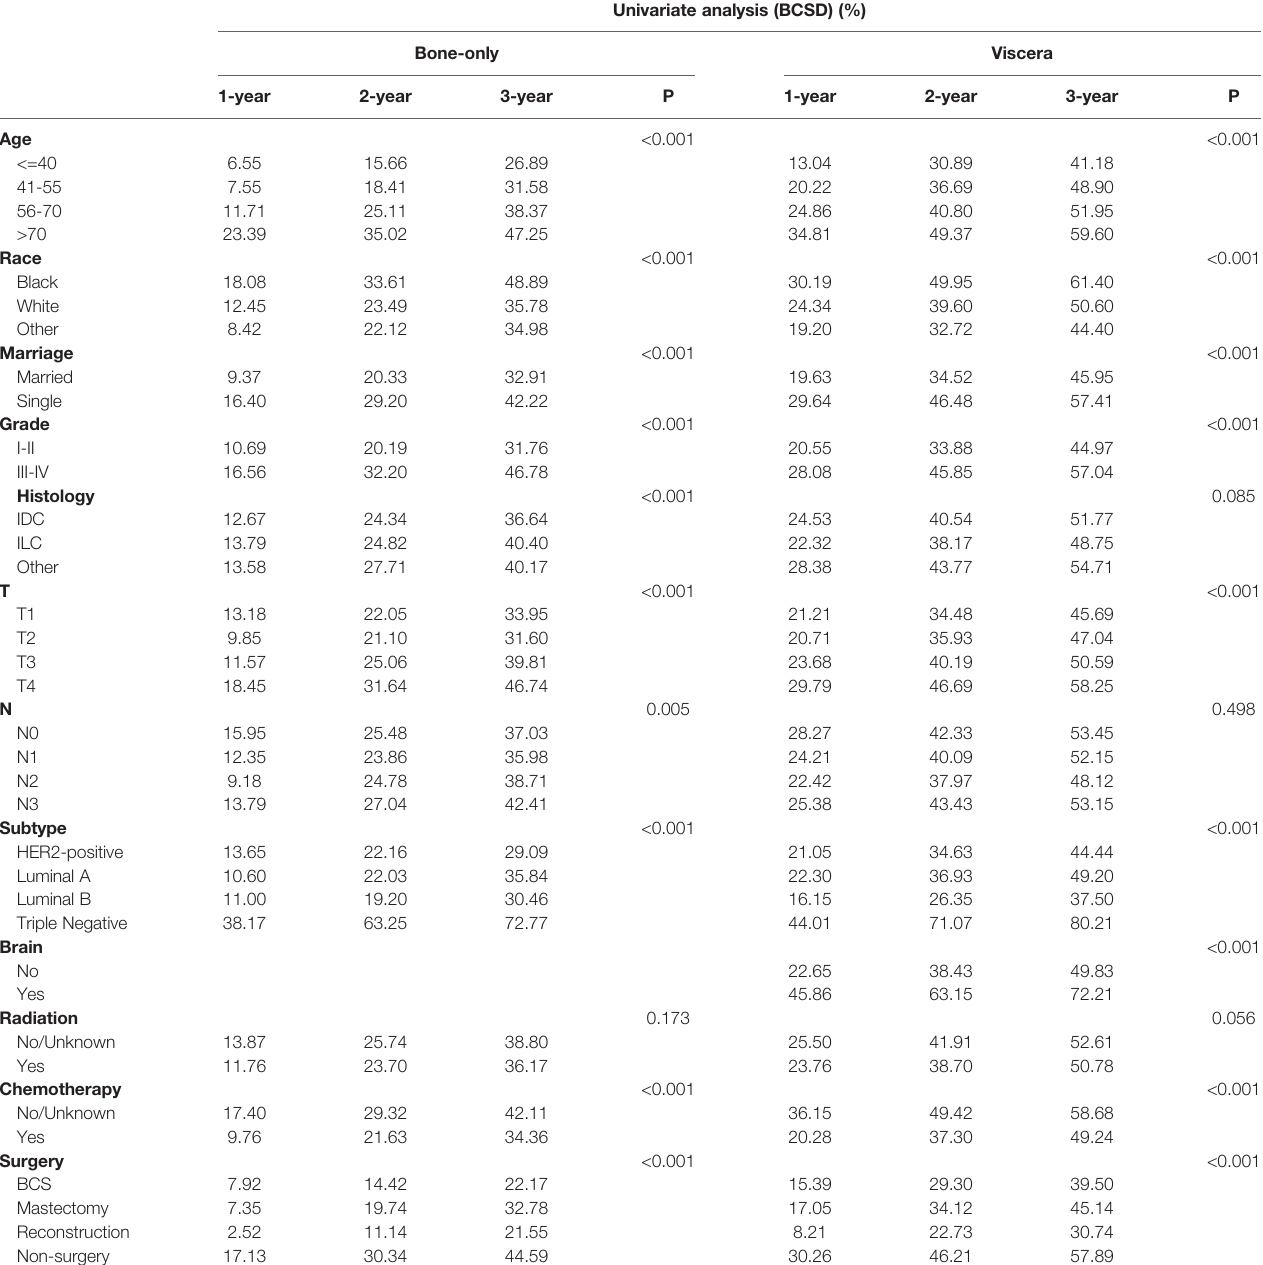
Univariate analysis (BCSD)